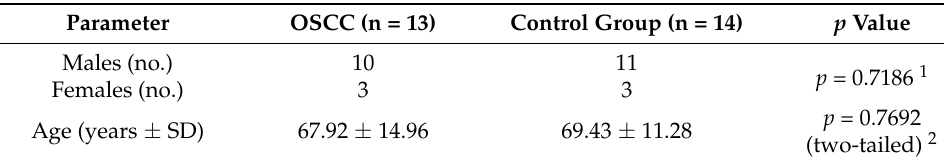
Table 1. Comparative characteristics of subjects included in the study.